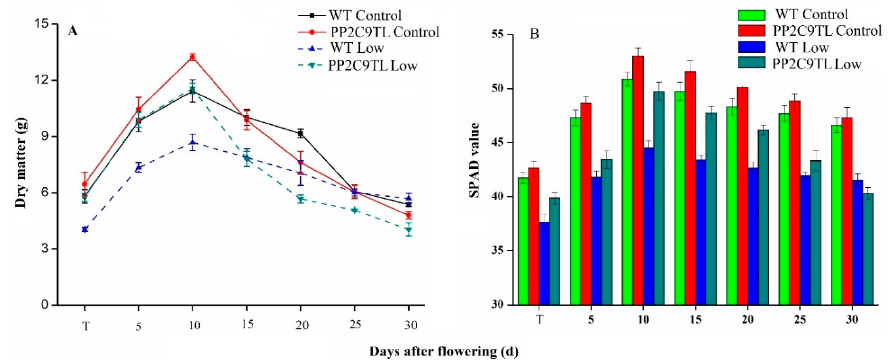
Figure 1. ( A ) The leaf dry matter (g) of PP2C9TL and WT at tillering (T), 5, 10, 15, 20, 25, and 30 DAF. ( B ) The chlorophyll contents of PP2C9TL and WT at tillering (T), 5, 10, 15, 20, 25, and 30 DAF.